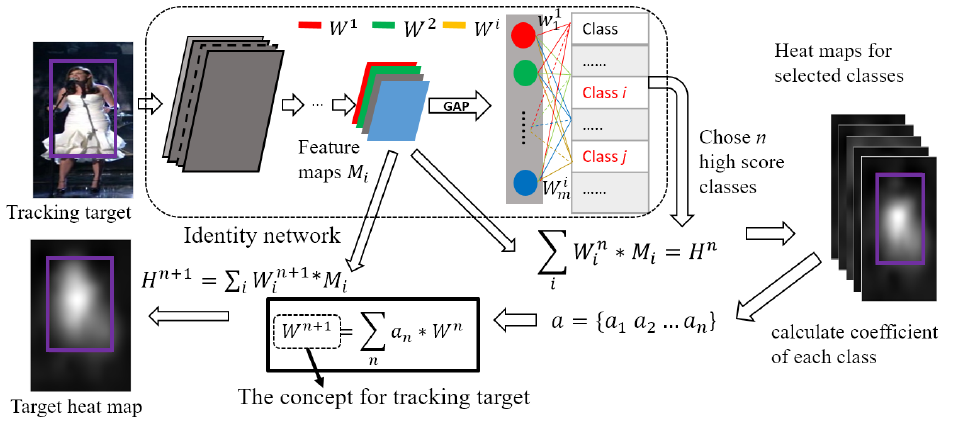
Figure 3. The new target concept estimation. Given a target, we can generate a number of heat maps for top n classes that the target may belong to like the red classes. Then based on the ground truth on the heat maps, the coefficients for the combination of these classes’ weights can be calculated to generate the new concept for the